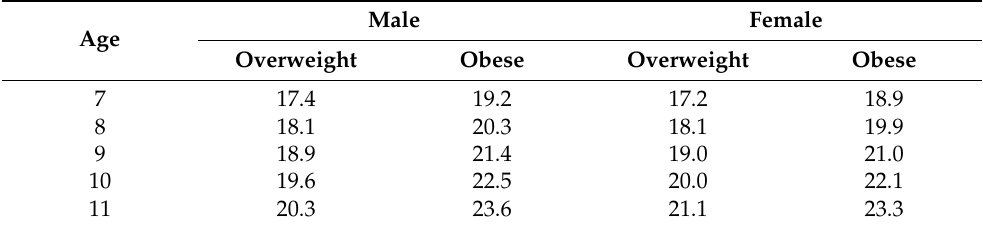
Table 1. China BMI reference norms (7–11